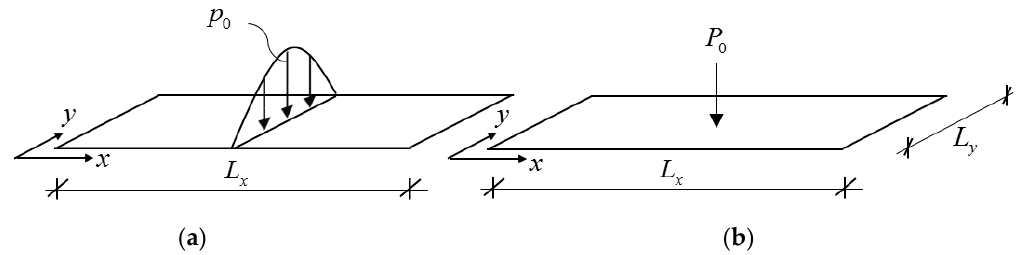
Figure 2. Long plate subjected to a trigonometrical line load ( a ) and to a concentrated load ( b ).